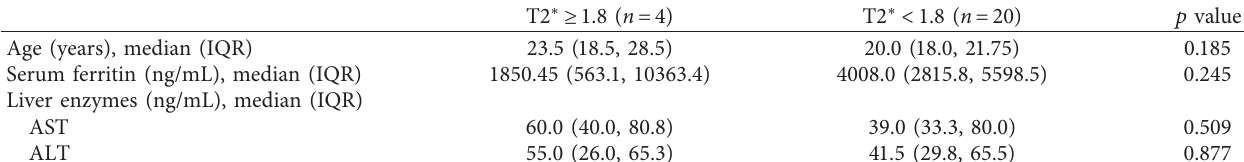
Table 3: Liver function stratified by presence of liver siderosis based on T2 ∗ MRI.